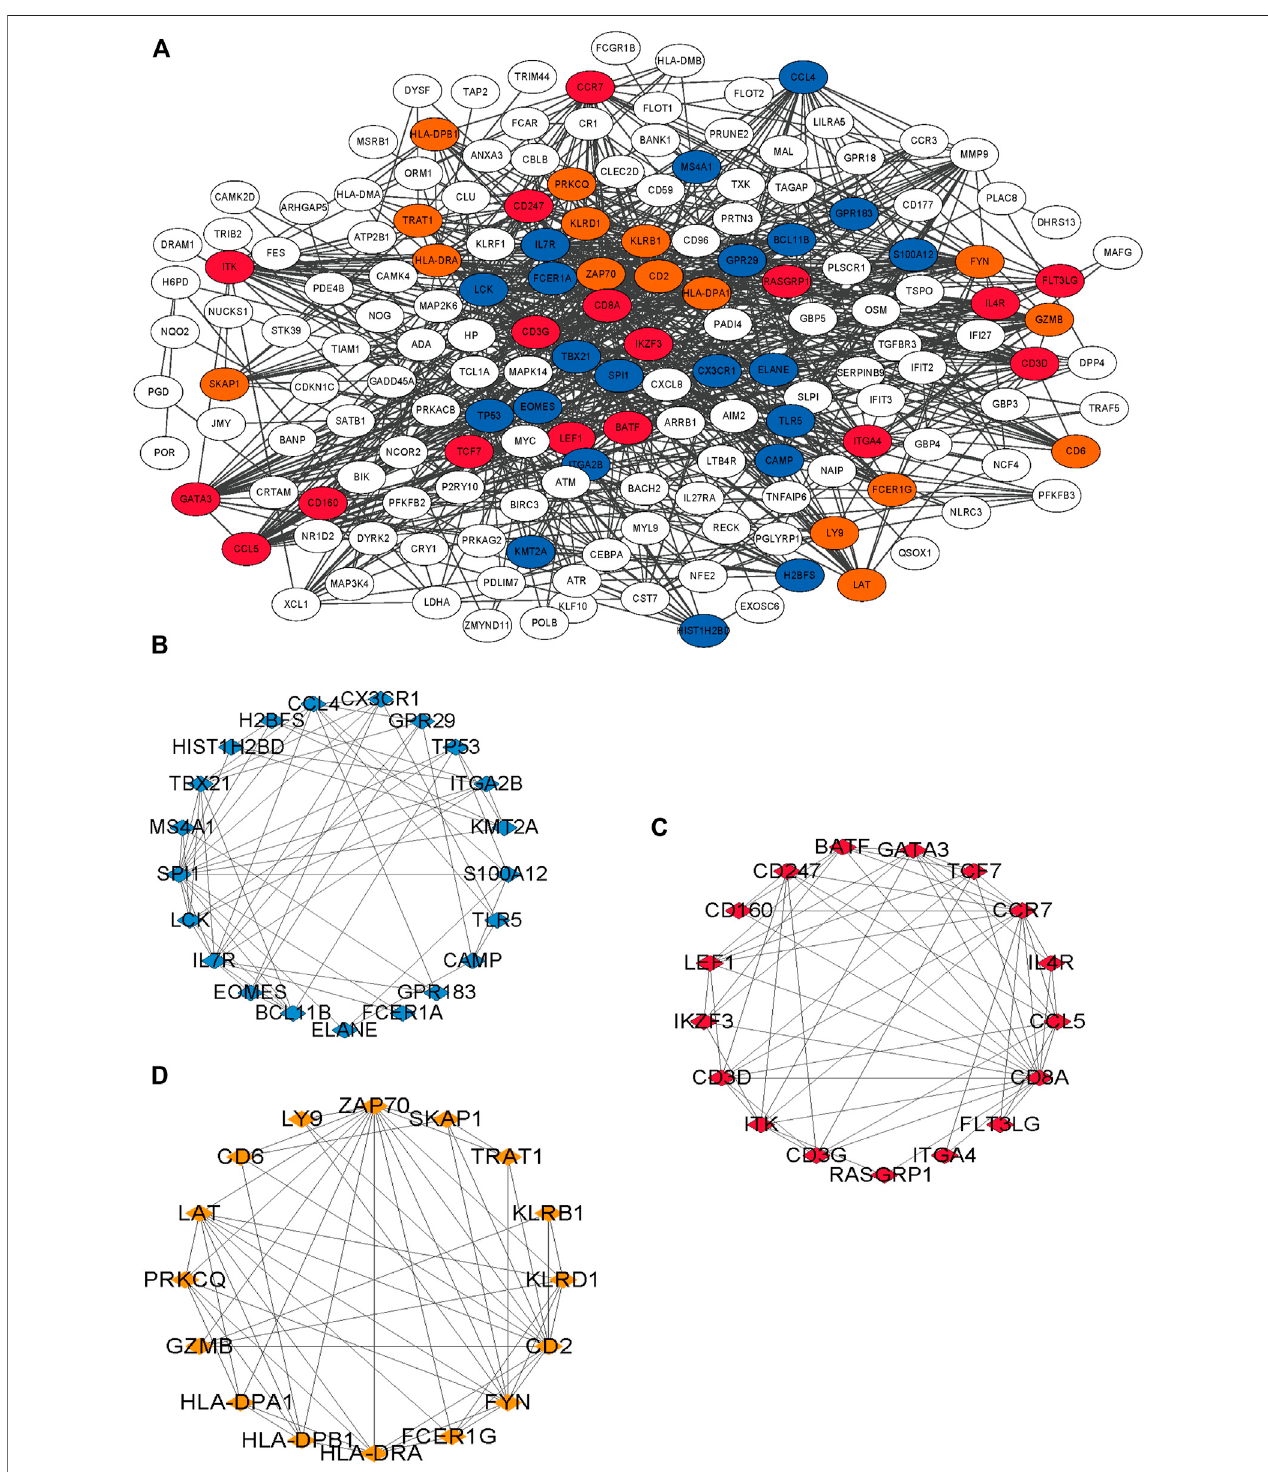
FIGURE 6| Results ofPPI networkof 210 immune-related genes. (A) The interaction of210 genes, different colors means differentinteraction groups. (B – D) Blue is module 1, orange is 2 and red is 3.